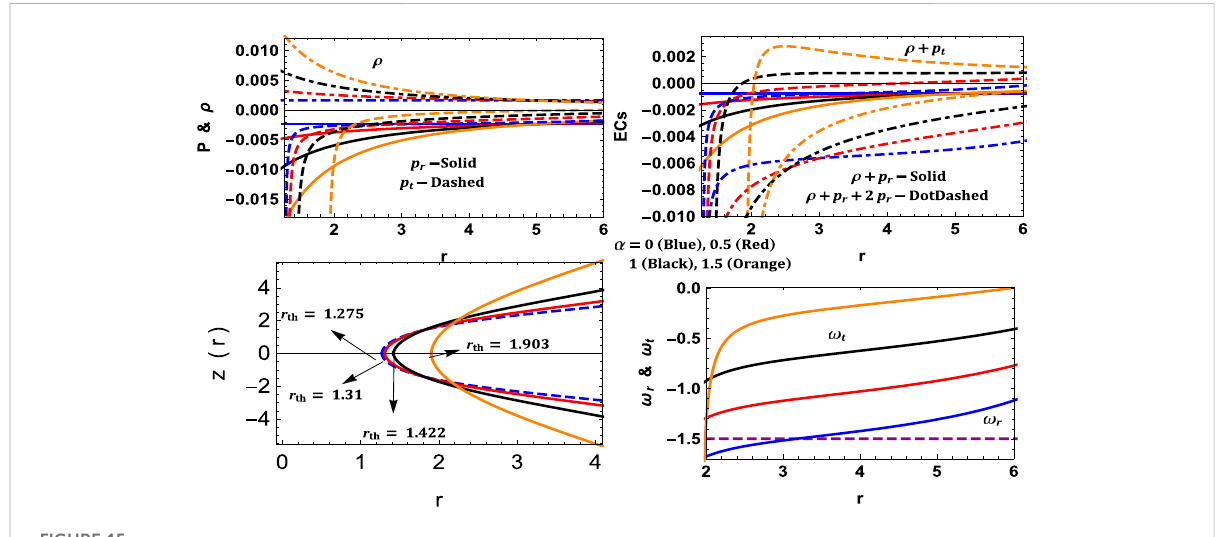
FIGURE 15 Variation of energy conditions and embedding surface for model VI with c = 0.04, λ = 1.2, F = 1.5, a = 5, ω = −